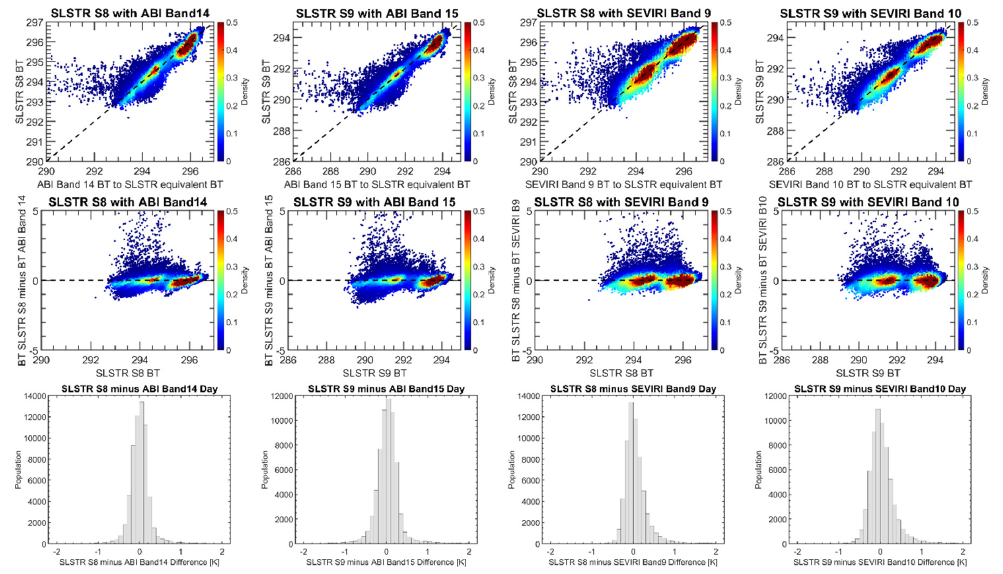
Figure 20. As shown in Figure 17, but for nighttime.